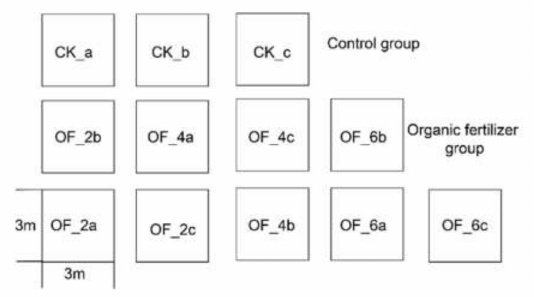
Figure 1. Layout of the experimental